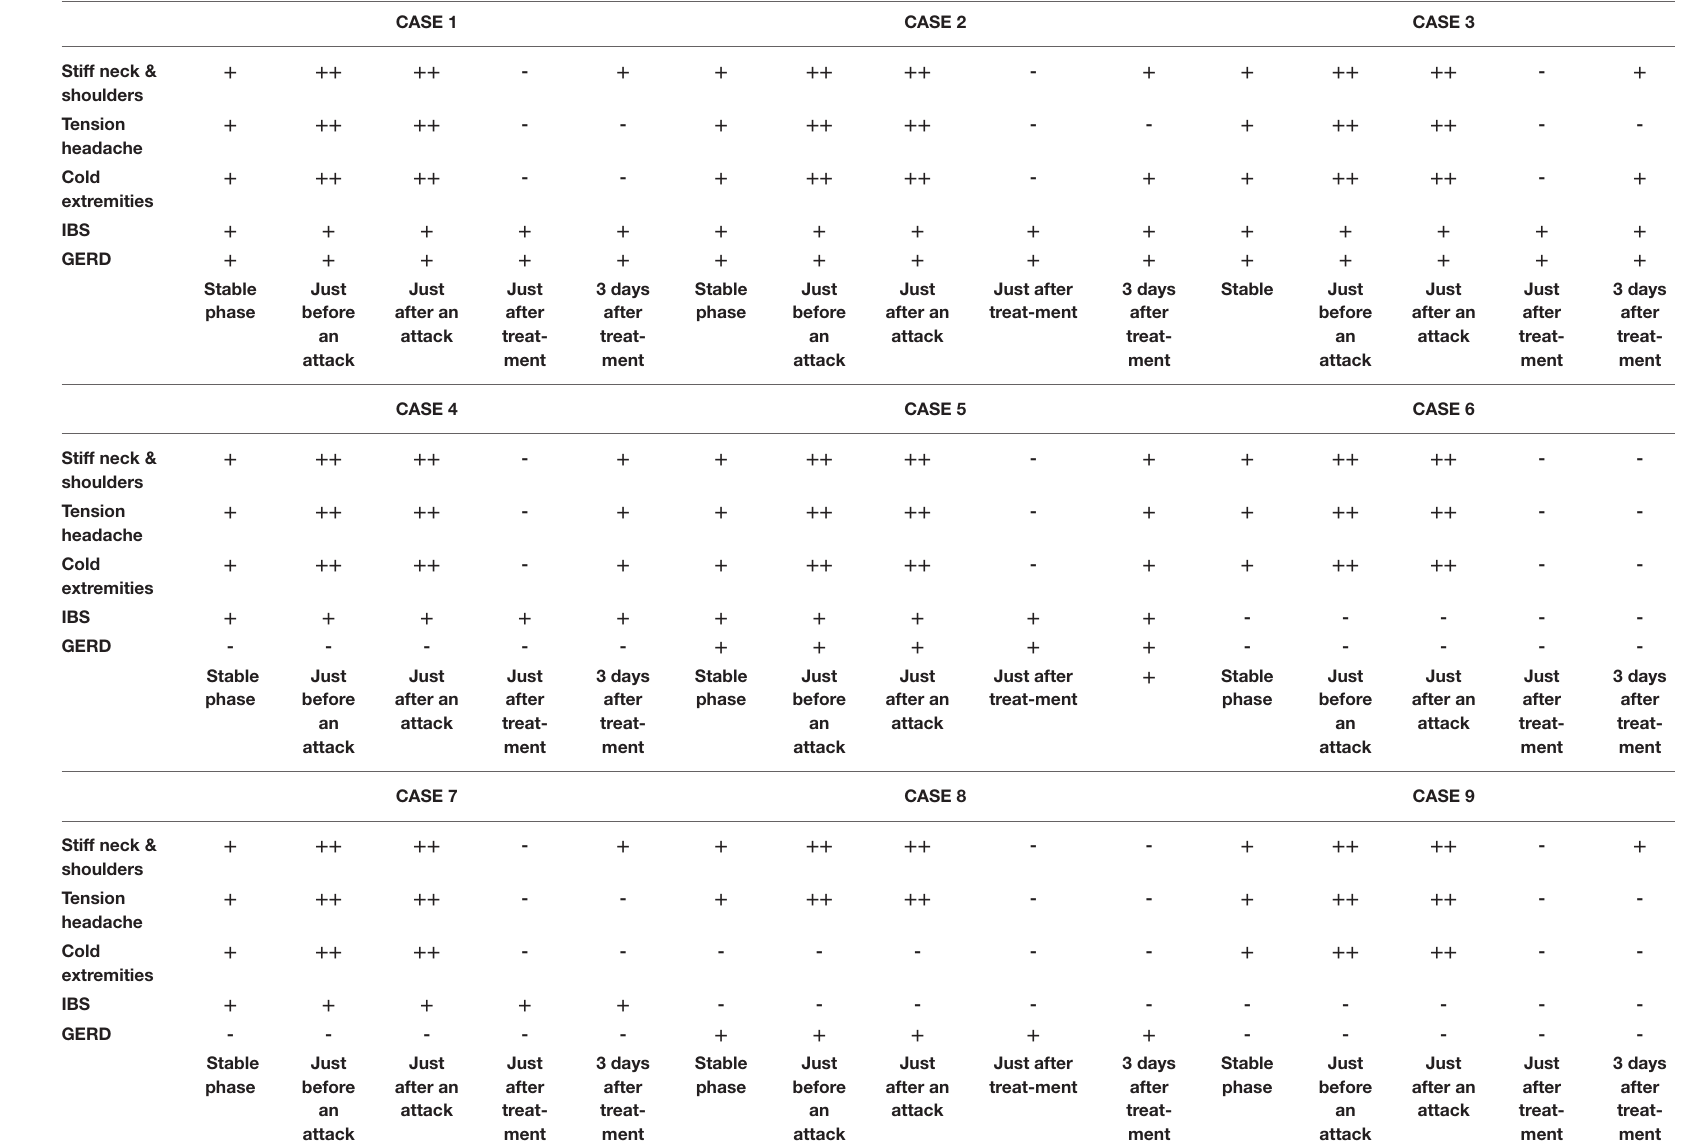
TABLE 3 | The treatment after an attack suppressed the hyperactivity of the sympathetic nervous system and restored the suppressed parasympathetic nervous